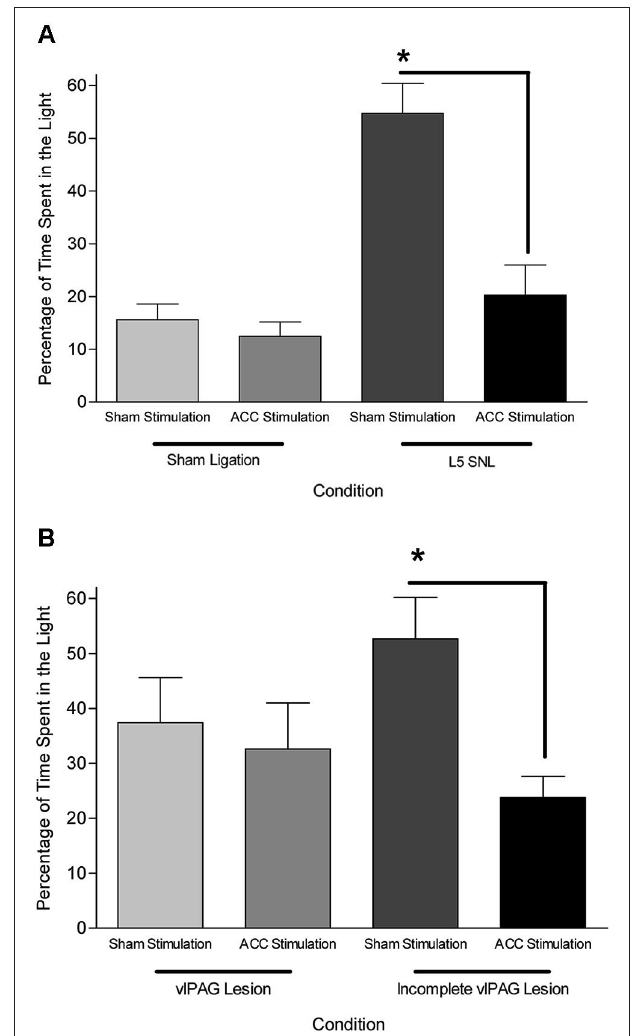
FIGURE 4 | (A) Mean ( ± SEM) time spent in the light side of the PEAP chamber in sham vlPAG lesioned animals. L5 SNL, Sham ACC stimulated animals avoided noxious hindpaw stimulation significantly more than sham ligated, sham ACC stimulated animals. ACC stimulation did not have an effect in sham ligated animals, but significantly attenuated the avoidance behavioral response in L5 SNL animals. * p < 0.05 compared to sham ligated + sham ACC stimulation treated animals. (B) Mean ( ± SEM) time spent in the light side of the PEAP chamber in L5 SNL animals with vlPAG lesions or incomplete vlPAG lesions. L5 SNL, Sham ACC stimulated animals with an incomplete lesion of the vlPAG avoided noxious hindpaw stimulation significantly more than L5 SNL, ACC stimulated animals with an incomplete vlPAG lesion. There was not a significant avoidance response following vlPAG lesions in ACC stimulated, L5 SNL animals. * p < 0.05 compared to sham ligated + sham ACC stimulation treated animals (Reprint from LaBuda and Fuchs,